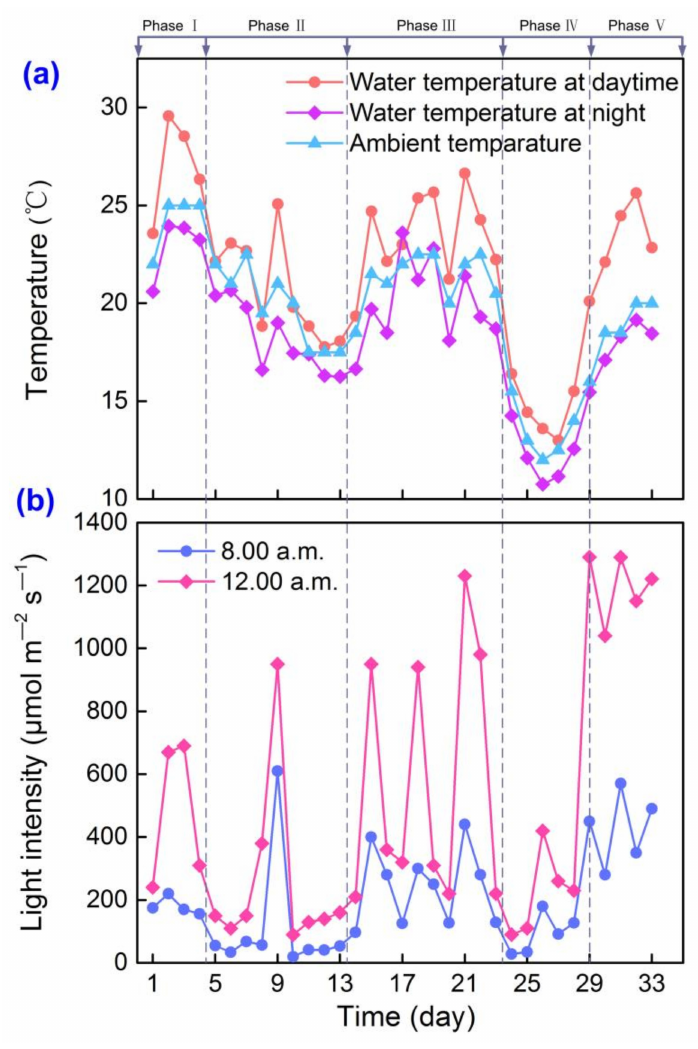
Figure 2. Experimental conditions in terms of average ambient temperature, water temperature ( a ) and light intensity ( b